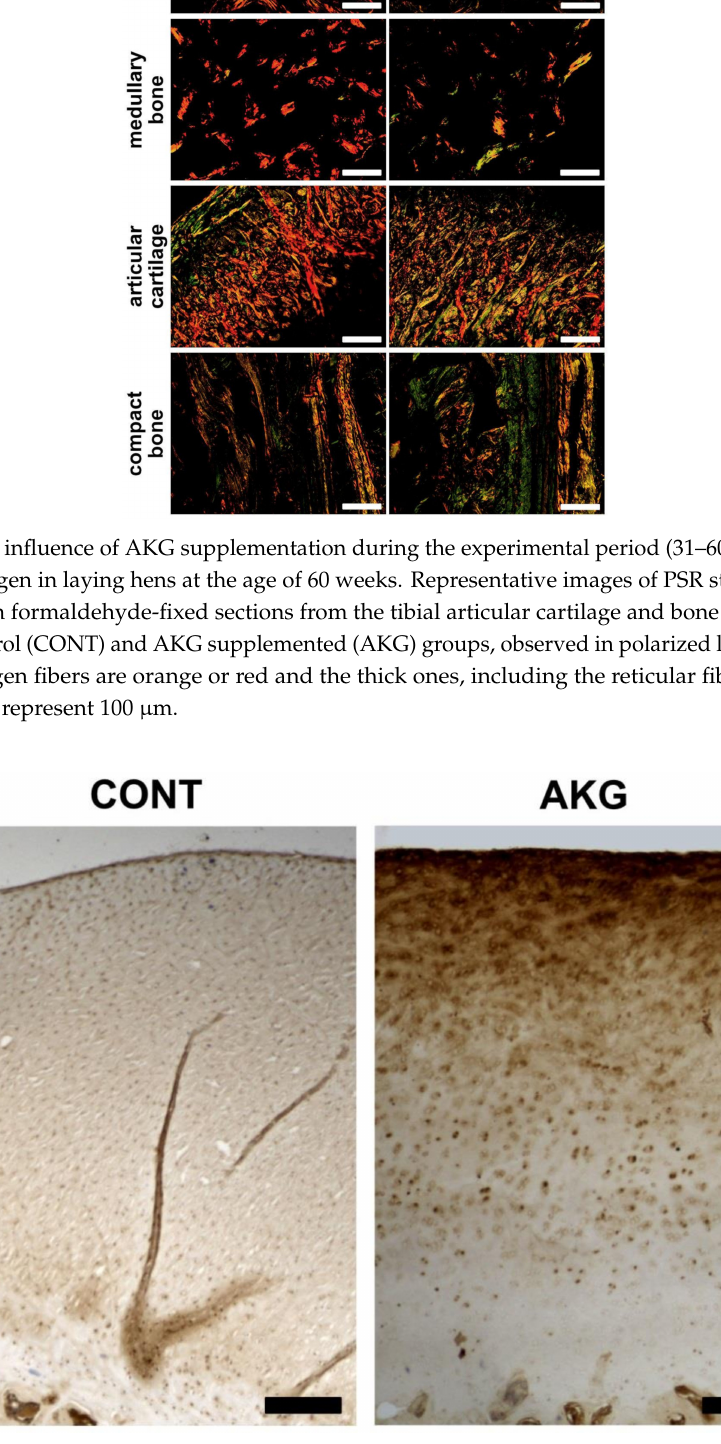
Figure 5. The influence of AKG supplementation during the experimental period (31–60 weeks of age) on the distribution of cartilage oligomeric matrix protein (COMP) in laying hens at the age of 60